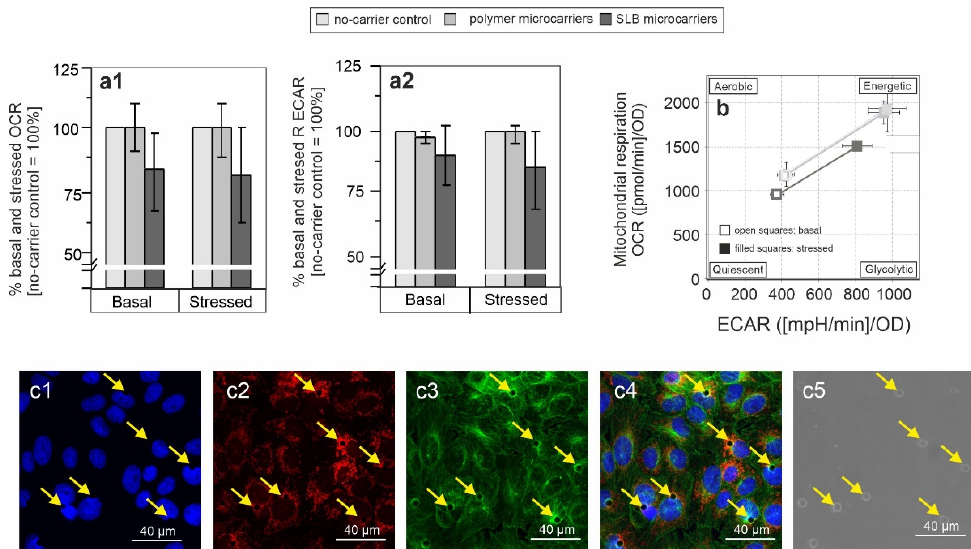
Figure 6. The early onset of SLB microcarrier-induced metabolic alterations in Vero cells was accompanied by their localization in close proximity to mitochondria. Vero cells were incubated with SLB microcarriers and processed for further analysis after 6 h of incubation. ( a , b ) The metabolic phenotype was determined by extracellular flux analysis using the cell energy phenotype test kit. Basal and stressed OCR ( a1 ) and ECAR ( a2 ) values were obtained before and after injection of the inhibitors FCCP and oligomycin, respectively. Normalized results are shown. ( b ) The metabolic potential under basal and stressed (after injection of the inhibitors) conditions was calculated after normalization by the energy phenotype test report generator software (n = 3, one-way ANOVA with Tukey’s post-hoc). ( c ) Immunofluorescence with antibodies against α -tubulin (shown in green) was performed after labelling of mitochondria with MitoTracker Red dye (shown in red). Nuclei are counterstained with DAPI and shown in blue, while SLB microcarriers are present in the visible light channel. Image size: 145 µm × 145 µm.